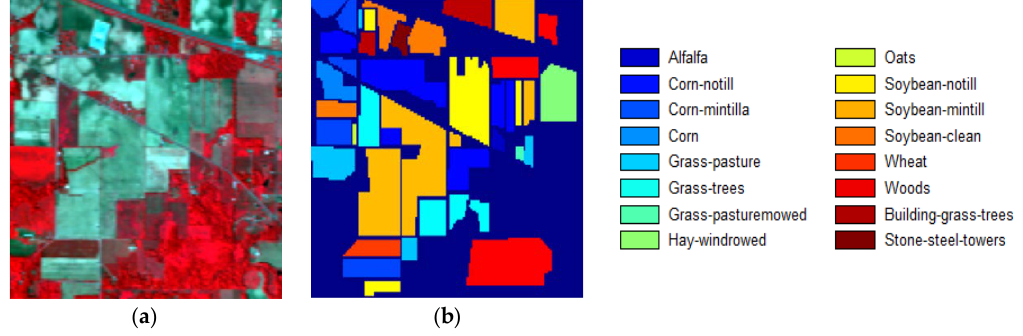
Figure 1. Indian Pines dataset. ( a ) False color composition; ( b ) Ground-truth.